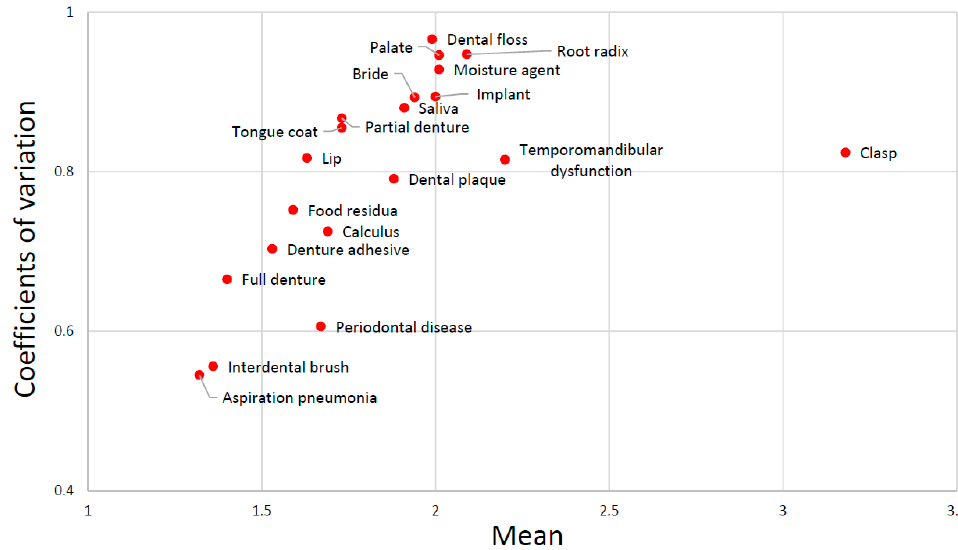
Figure 2. Relationship between the mean and coefficients of variation of the score.